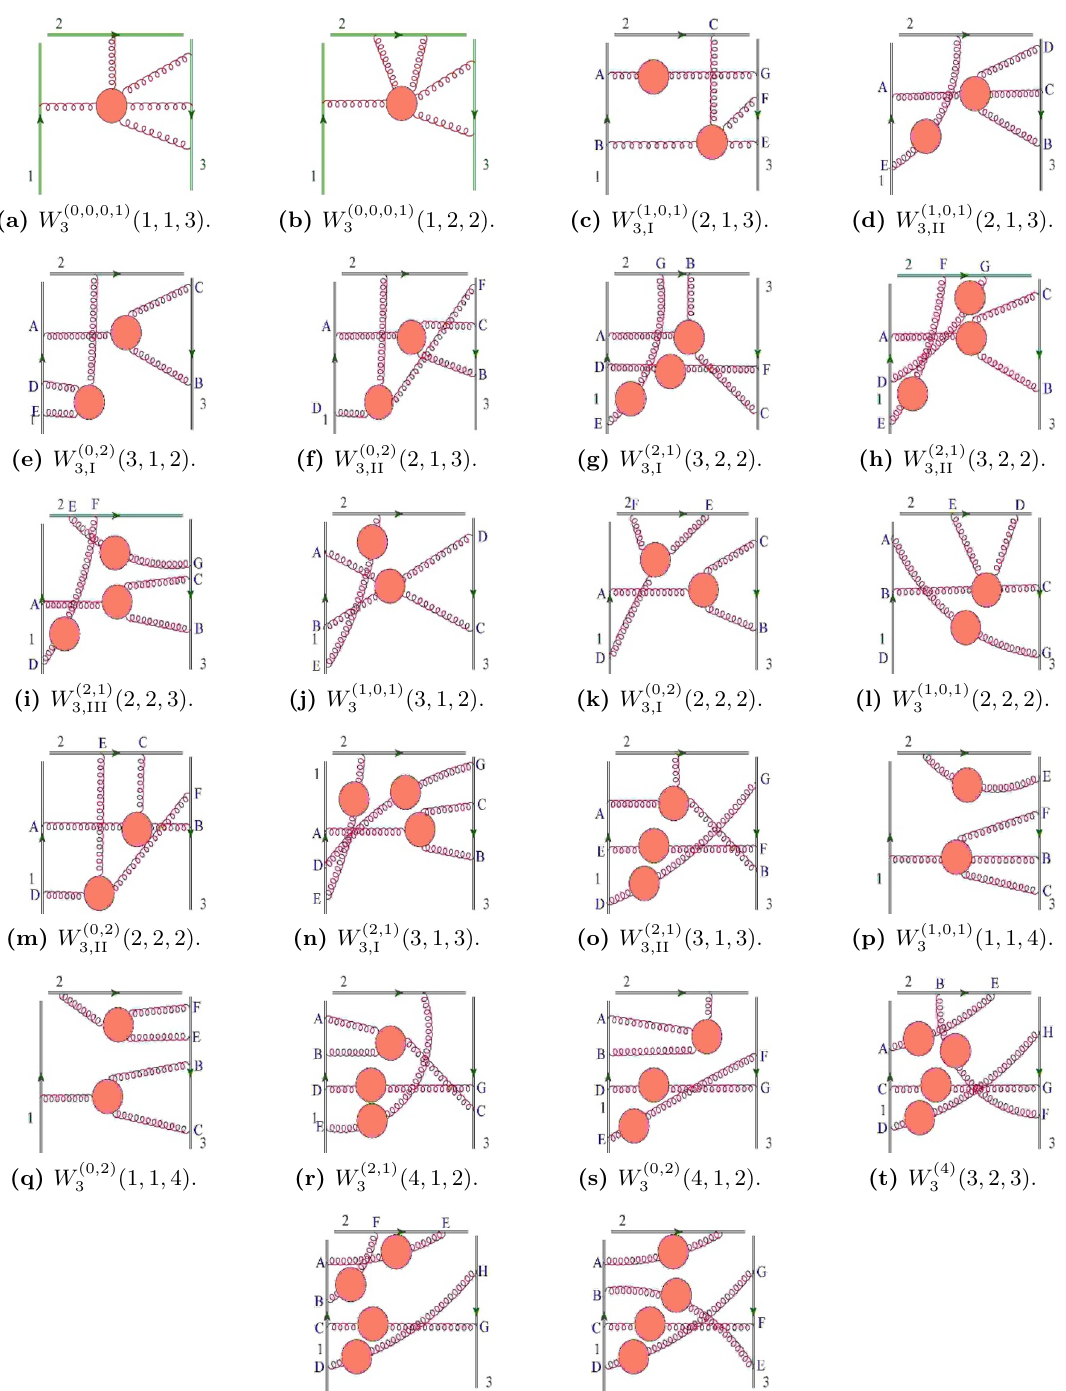
Figure 4. Representative skeleton diagrams for the twenty-two four-loop Cwebs connecting three Wilson lines in a massless theory. The dimensions of the associated mixing matrices are d { 1 , 1 , 6 , 2 , 3 , 6 , 24 , 6 , 12 , 3 , 2 , 4 , 8 , 18 , 18 , 4 , 6 , 24 , 12 , 36 , 24 , 24 } , in the order